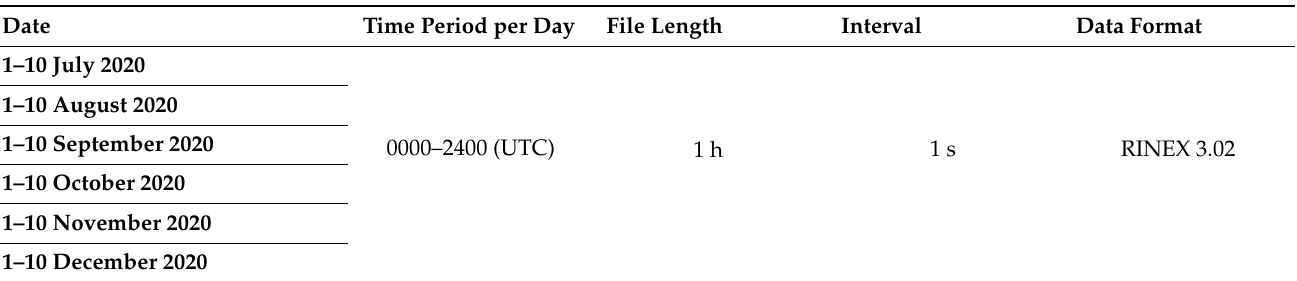
Table 4. Observation/data file information of the GNSS data quality assessment of the Hong Kong SatRef services.